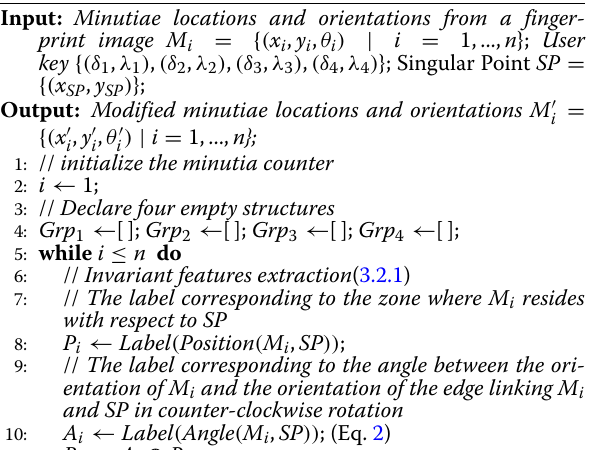
Algorithm 1 Generation of a protected